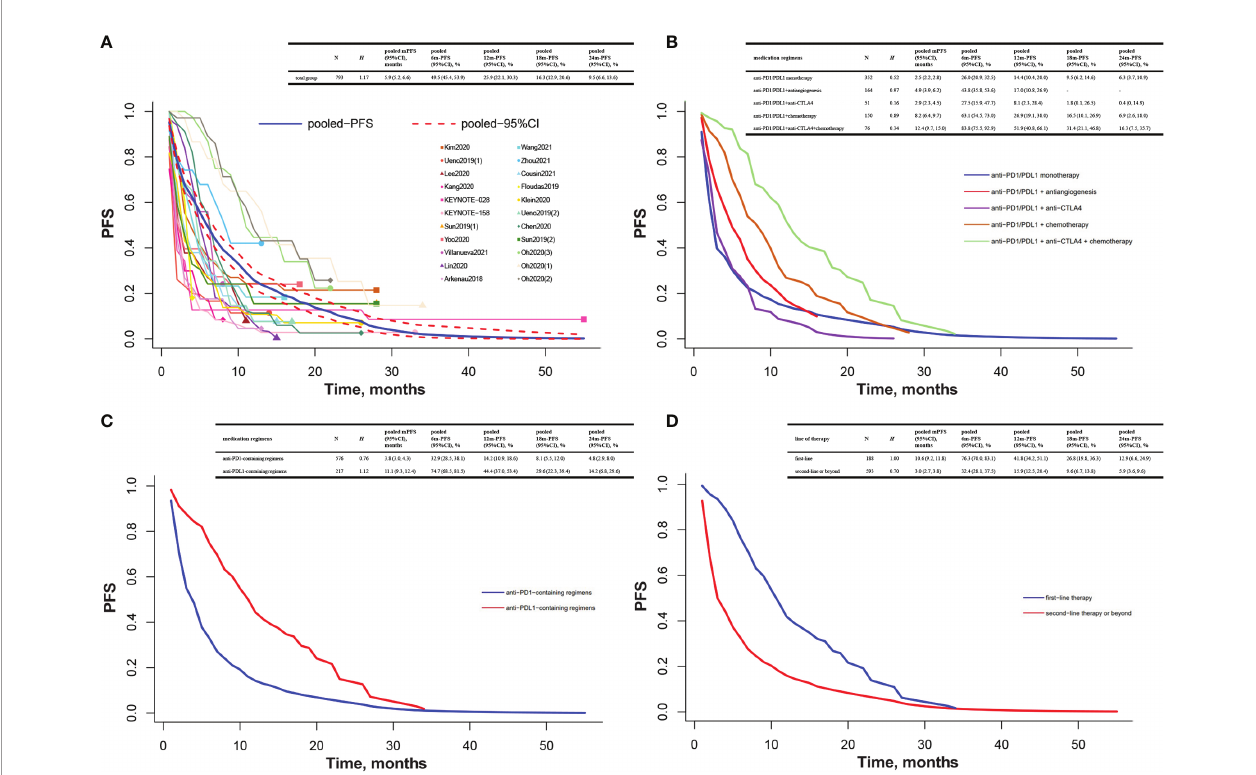
FIGURE 2 | Pooled Kaplan – Meier estimate of PFS. (A) Total group; (B) anti-PD1/PDL1 monotherapy, anti-PD1/PDL1 combined with antiangiogenesis or anti- CTLA4 or chemotherapy, or combination of anti-PD1/PDL1, anti-CTLA4, and chemotherapy; (C) anti-PD1-containing regimens and anti-PDL1-containing regimens; (D) fi rst-line therapy and second-line therapy or beyond. Note: Heterogeneity was assessed by H statistic, with H < 1.2 considered as being indicative of insigni fi cant heterogeneity. Three studies had more than one subgroup of interest. Speci fi cally, patients were allocated to the nivolumab group [Ueno2019(1)] or the nivolumab/ GemCis group [Ueno2019(2)] in the Ueno2019 study; the PD1 inhibitor monotherapy group [Sun2019(1)] or the PD1 inhibitor plus chemotherapy group [Sun2019(2)] in the Sun2019 study; the biomarker group [receiving durvalumab/tremelimumab with GemCis, [Oh2020(1)], the durvalumab/tremelimumab with GemCis group [Oh2020(2)], or the durvalumab with GemCis group [Oh2020(3)] in the Oh2020 study. PFS, progression-free survival; mPFS, medium progression-free survival; CI, con fi dence interval; 6m-PFS, 6-month progression-free survival; 12m-PFS, 12-month progression-free survival; 18m-PFS, 18-month progression-free survival; 24m- PFS, 24-month progression-free survival; PD1, programmed cell death protein 1; PDL1, programmed cell death ligand 1; CTLA4, cytotoxic T lymphocyte antigen 4; GemCis, gemcitabine +